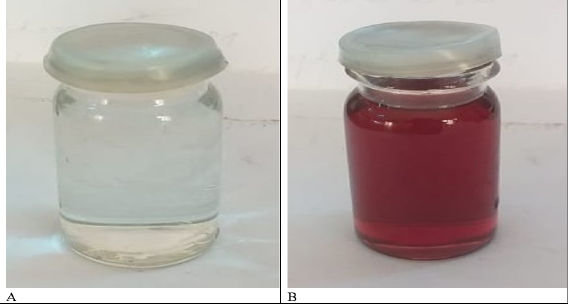
Figure 2. ( A ) Bulb extract + AgNO 3 solution before reaction. ( B ) Bulb extract + AgNO 3 solution after reaction.